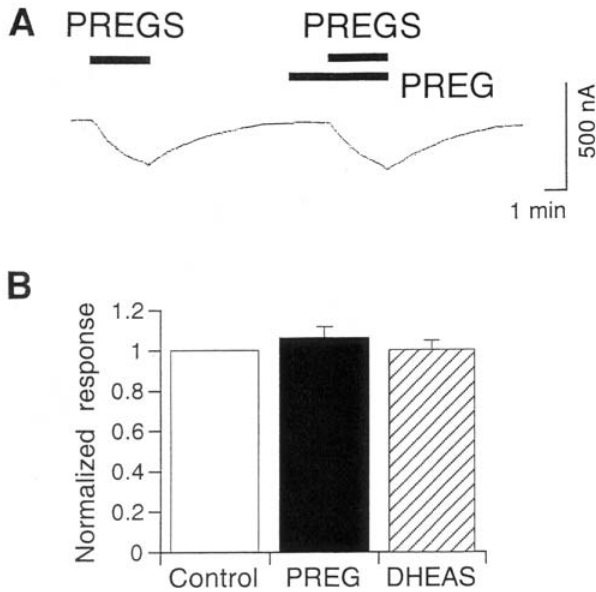
Figure 5. Concentration-response relationships for potentia- tion of Kir2.3 channels by PREGS at different pH values. The magnitudes of potentiation of Kir2.3 currents by PREGS in oocytes expressing Kir2.3 channels were normalized to the 3 mM Ba 2 + -sensitive current components, which were 426.9.6 6 41.4 nA (pH 6.0), 554.0 6 79.9 nA (pH 7.4) and 729.2 6 36.6 nA (pH 9.0). The EC 50 and n H values were 16.1 6 1.2 m M and 1.44 6 0.07 (pH 6.0, n =10), 15.6 6 0.9 m M and 1.43 6 0.03 (pH 7.4, n =6), and 17.1 6 1.5 m M and 0.70 6 0.03 (pH 9.0, n =8), respectively. Current responses were measured at a membrane potential of 2 70 mV in an hK solution containing 96 mM K + . Data are expressed as mean 6 SEM of the percentage responses.